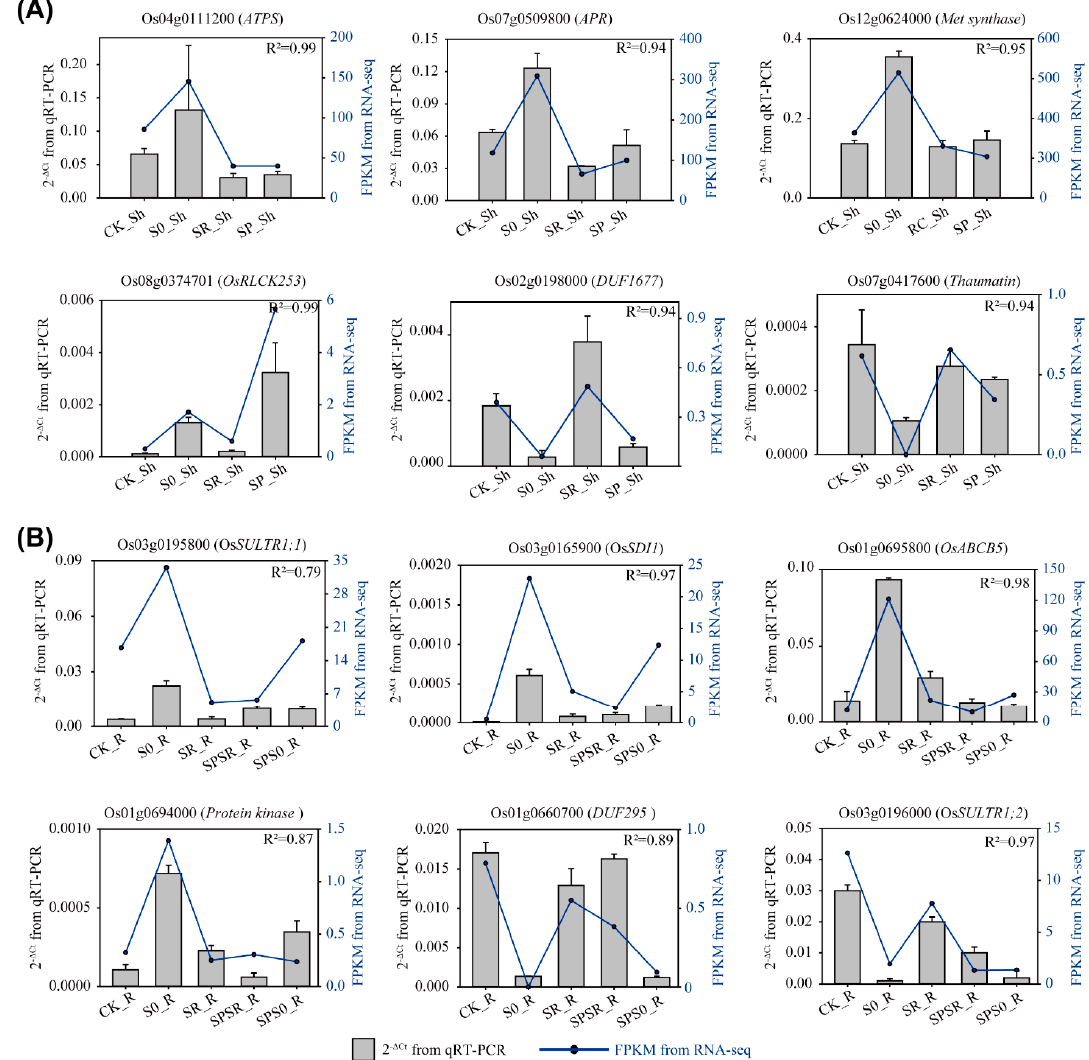
Figure 6. qRT-PCR verification of the expression pattern of selected DEGs in response to sulfate resupply. ( A ) The relative expression levels determined by qRT-PCR and the FPKM values from RNA-seq of six genes in shoots. ( B ) The relative expression levels determined by qRT-PCR and the FPKM values from RNA-seq of six genes in roots. The relative expression levels determined by qRT- PCR were presented as 2 −∆ Ct using the rice Actin gene as internal reference gene. The gray columns indicated the 2 −∆ Ct values from qRT-PCR, and blue lines represented FPKM values from RNA-seq. Pearson correlation coefficient (R 2 ) between 2 −∆ Ct and FPKM value was calculated using SPSS 22.0. CK, control; S0, S deficiency; SR, sulfate resupply in both sides of split-roots; SPSR, the split-root halve with sulfate resupply; SPS0, the split-root halve remained in S deficiency. Sh, shoot; R, root.